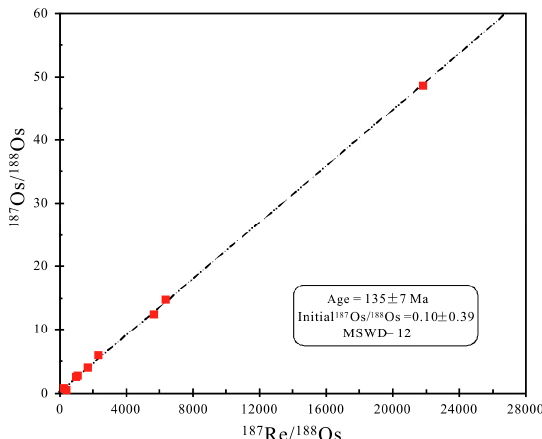
Figure 7. Re-Os isochron ages of quartz porphyry of the Weilasituo Sn-polymetallic deposit.